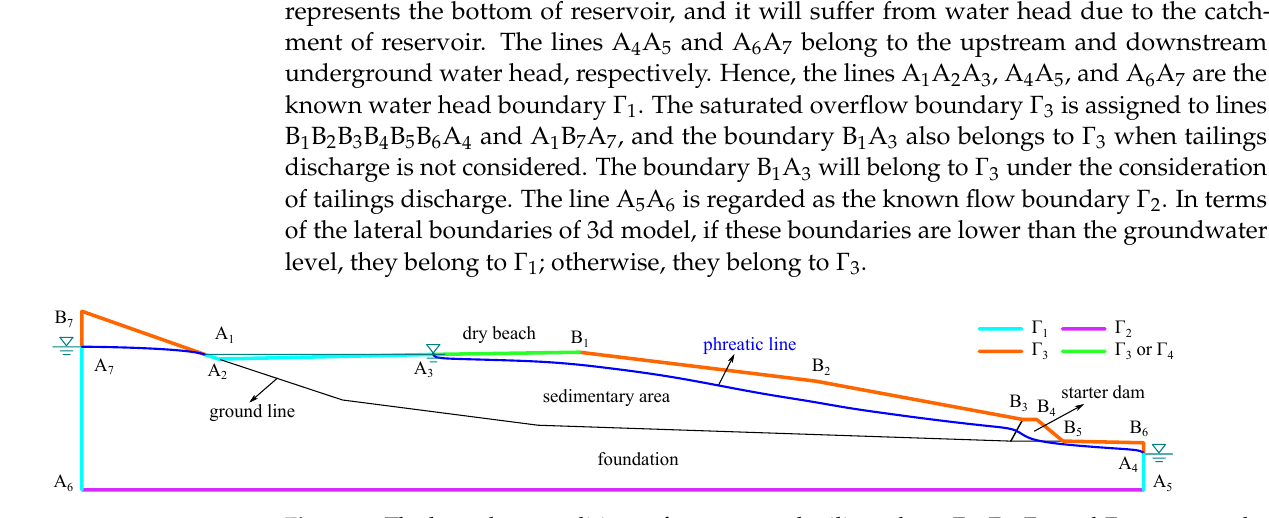
Figure 3. The boundary conditions of a conceptual tailings dam. Γ 1 , Γ 2 , Γ 3 , and Γ 4 represent the known water head boundary, known flow boundary, saturated overflow boundary, and unsaturated zone overflow boundary,